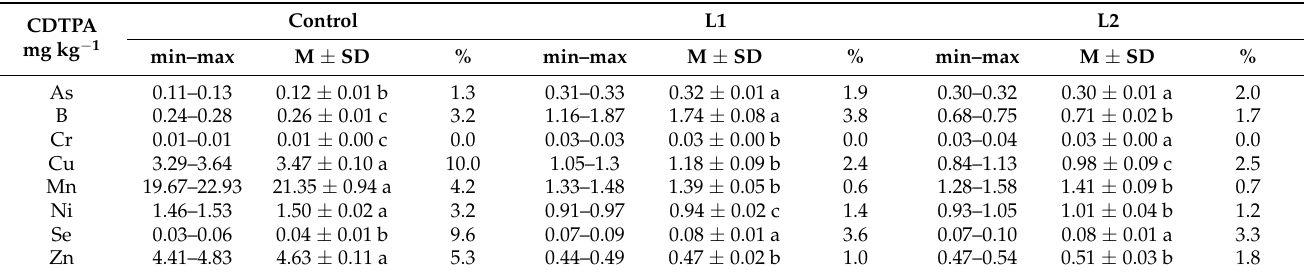
Table 2. Bioavailable (CDTPA) concentrations of heavy metal(loid)s in fly ash (L1 and L2) and soil (Control), and the share of the bioavailable fraction in the total content (%).